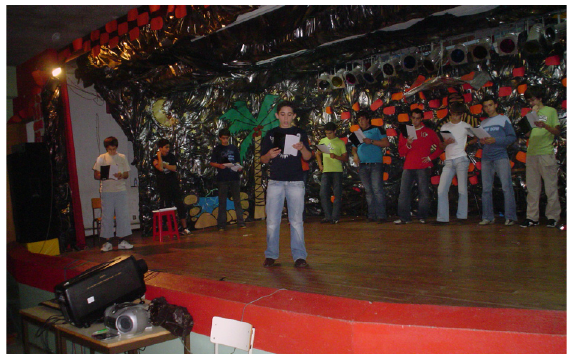
4 | Fig. 4: 9th graders practicing the dramaturgical–mu- sical theatrical